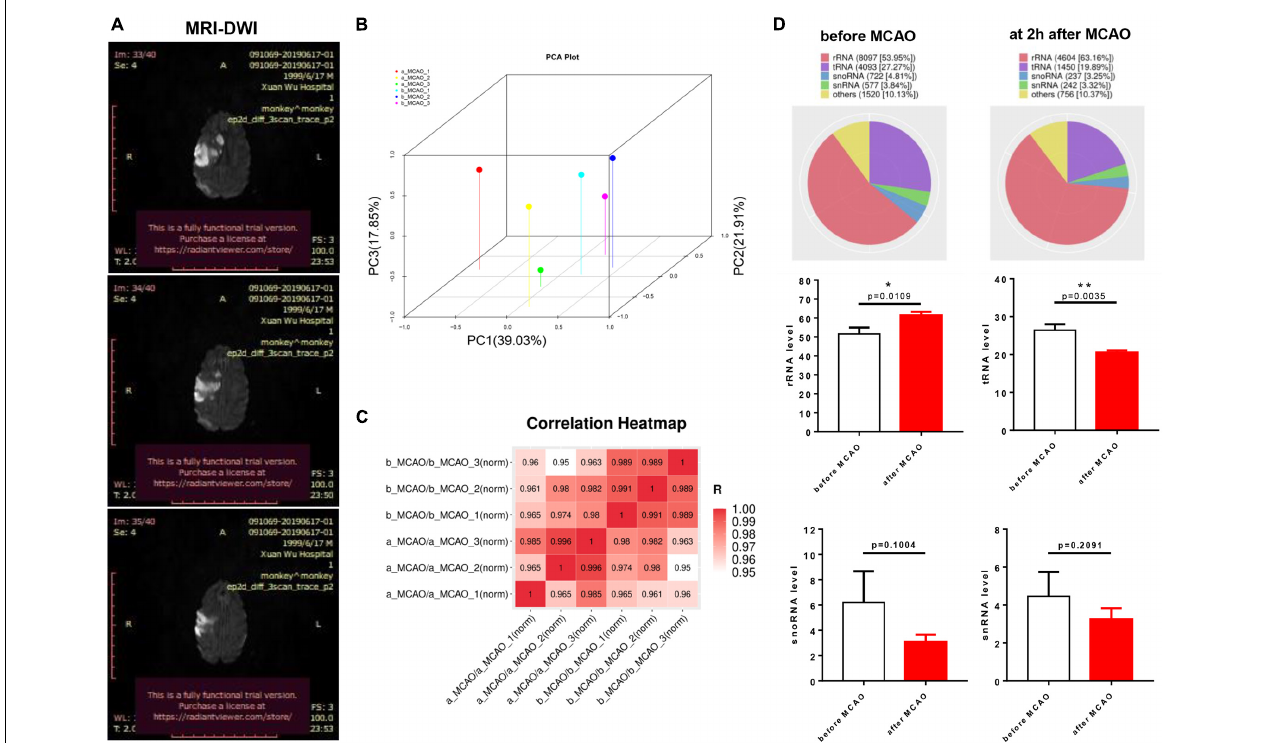
FIGURE 1 | Biological replication and Rfam sequence category of plasma miRNAs libraries of rhesus monkey before and after cerebral ischemia. (A) Magnetic resonance imaging with diffusion-weighted imaging (MRI-DWI) (1 day) identified infarct site in models. (B) Principle component analysis (PCA) of plasma of rhesus monkey before cerebral ischemia compared with after cerebral ischemia. (C) Pearson correlation coefficients between samples using genes of P < 0.05. (D) Rfam classification among the other non-coding RNAs (e.g., rRNAs, tRNAs, snRNAs, and snoRNAs). b_MCAO_1-3, before ischemia; a_MCAO_1-3, after ischemia. N = 3. * p < 0.05 and ** p <